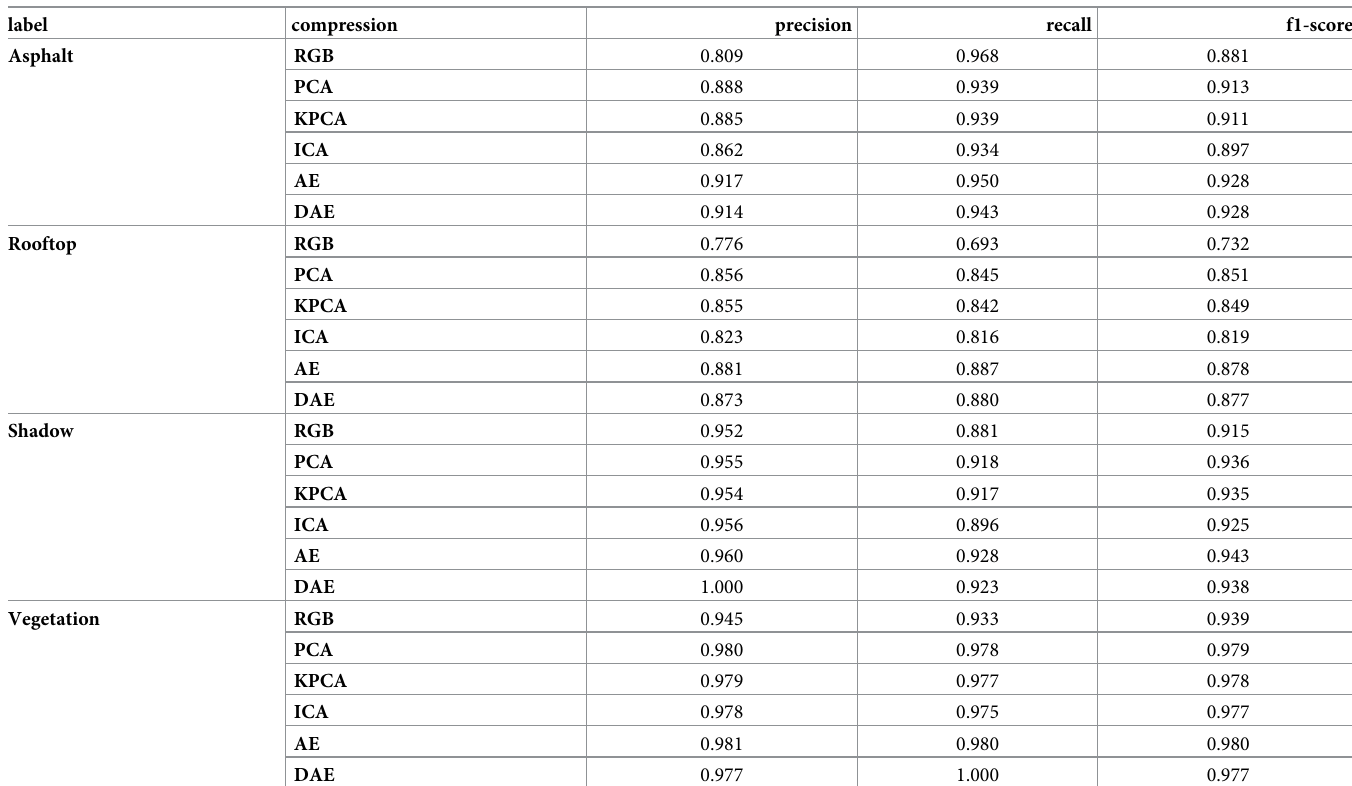
Table 4. Top classification scores Suburban, HSI, compression rate = 95%.